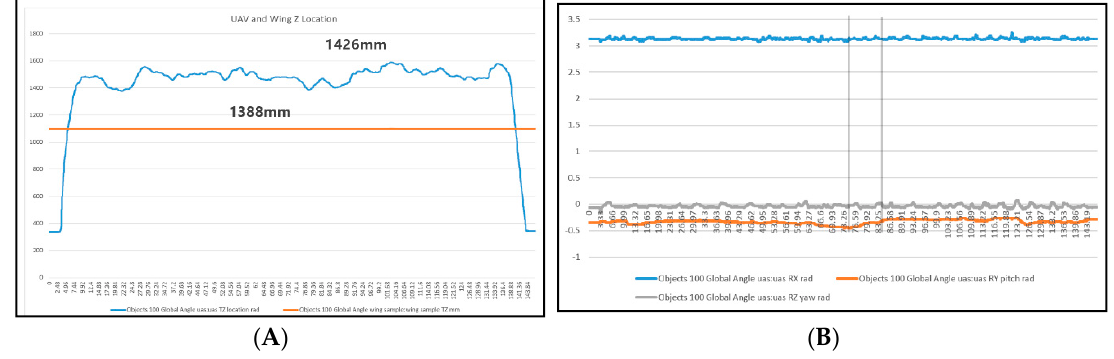
Figure 21. ( A ) The z -axis shows the flight envelope: 1426 mm − 1388 mm = 38 mm. ( B ) Graph demonstrating the stability of the UAV in flight. This was measured by the roll along the x -axis, pitch along the y -axis, and yaw along the z -axis.